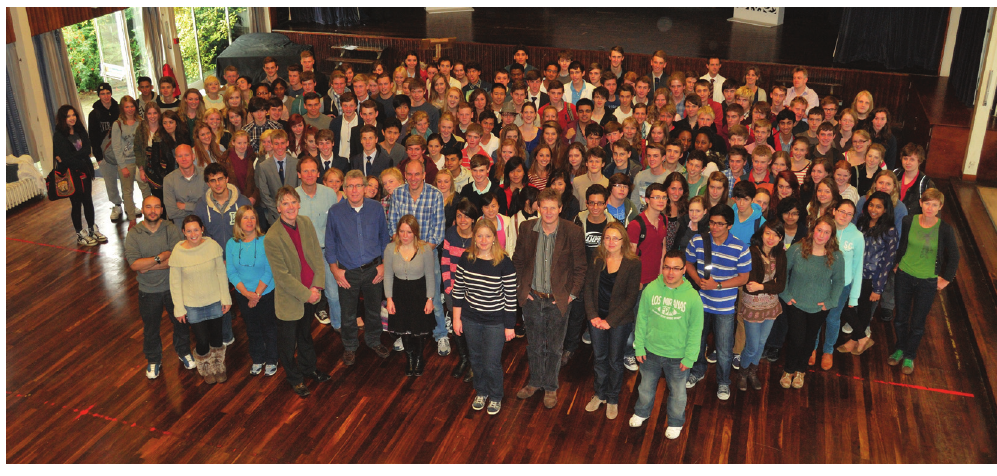
Figure 1: The class of 2012, with University of Kent staff in the foreground